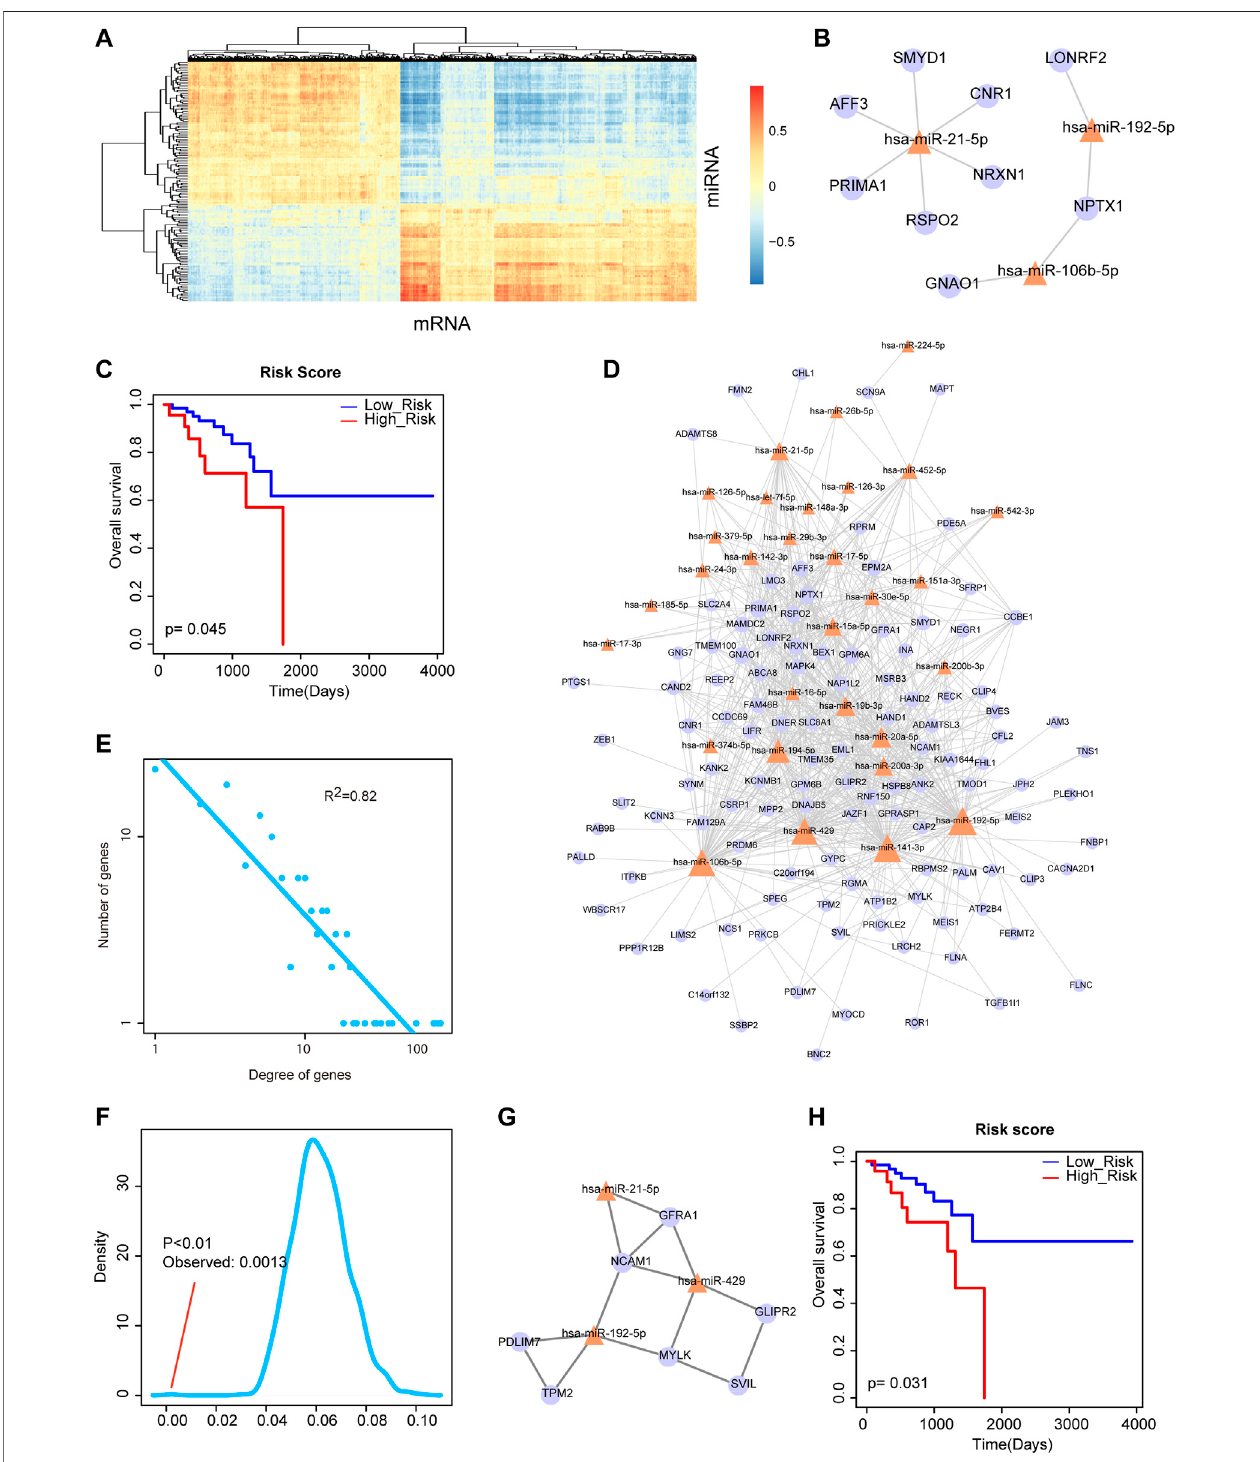
FIGURE 2 | Analysis of miRNA-mRNA network and its functional module. (A) The heat map of correlations between DE miRNAs and DE mRNAs. (B) The most negativelyexpression-correlated 10DEmiRNA-DEmRNA interaction pairs. miR-21-5p wasahub node with thelarge degree. (C) AKaplan-Meier survivalcurve of miR- 21-5p and its six direct neighbors ( p = 0.045). (D) The rectal cancer-related miRNA-mRNA network. Yellow triangle represents miRNA and purple circular represents mRNA.Nodesizerepresentsdegreeofnode. (E) Degreedistribution ofthenetwork.Allnodes followapower-law distribution. (F) Averageclustercoef fi cient ofthe real network was signi fi cantly larger than that of 1,000 random networks. (G) A functional module identi fi ed from the miRNA-mRNA network by MCODE. (H) A Kaplan- Meier survival curve of the three miRNAs of the module, miR-21-5p , miR-429 and miR-192-5p ( p = 0.031).